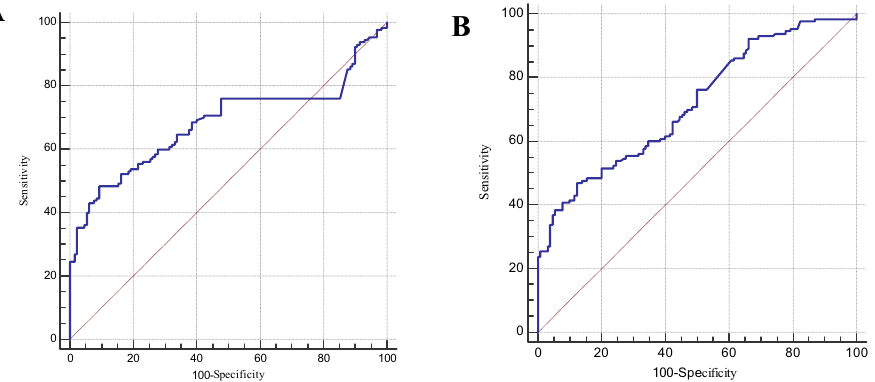
Figure 3. ROC curves of AFP. ( A ) ROC curves of AFP for HCC from CHB (0.683, 95% CI 0.623–0.739, P = 0.026) ( B ) ROC curves of of AFP for HCC from LC (0.716, 95% CI 0.657–0.770, P < 0.001).